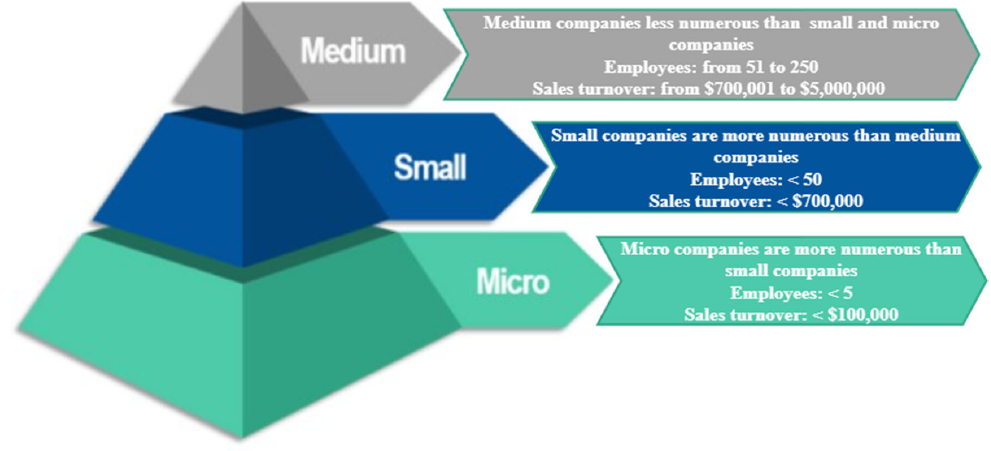
Figure 1. SMEs classification in Libya. Source: Ministry of Industry—Libya (2020).